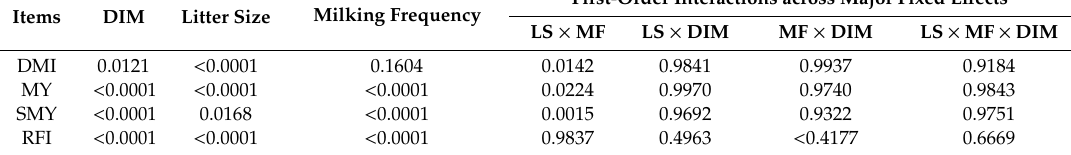
Table 2. Significance ( p -value) of the fixed e ff ects lactation stage (days in milk, DIM), litter size (LS), milking frequency (MF), and their interactions on residual feed intake (RFI, kg / ewe / d) and other zootechnical parameters linked to feed e ffi ciency of primiparous Lacaune dairy ewes during lactation (42–98 DIM).